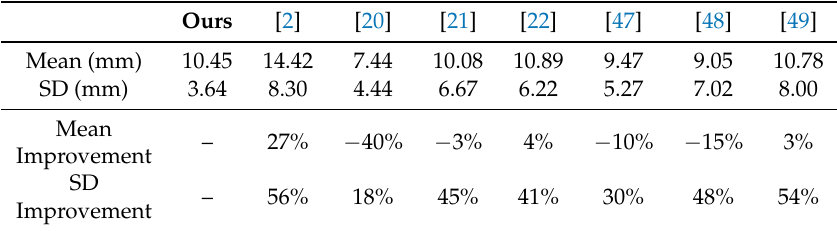
Table 5. The numerical improvements between our system with [2,20–22,47–49] on the NYU data-set. We consider the the mean value and the standard deviation(SD) of the joints error.